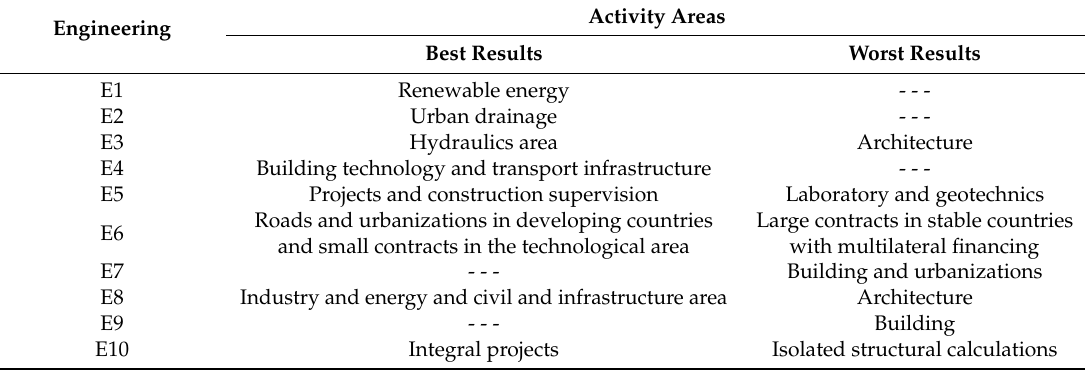
Table 6. Internationalized activity areas and results.